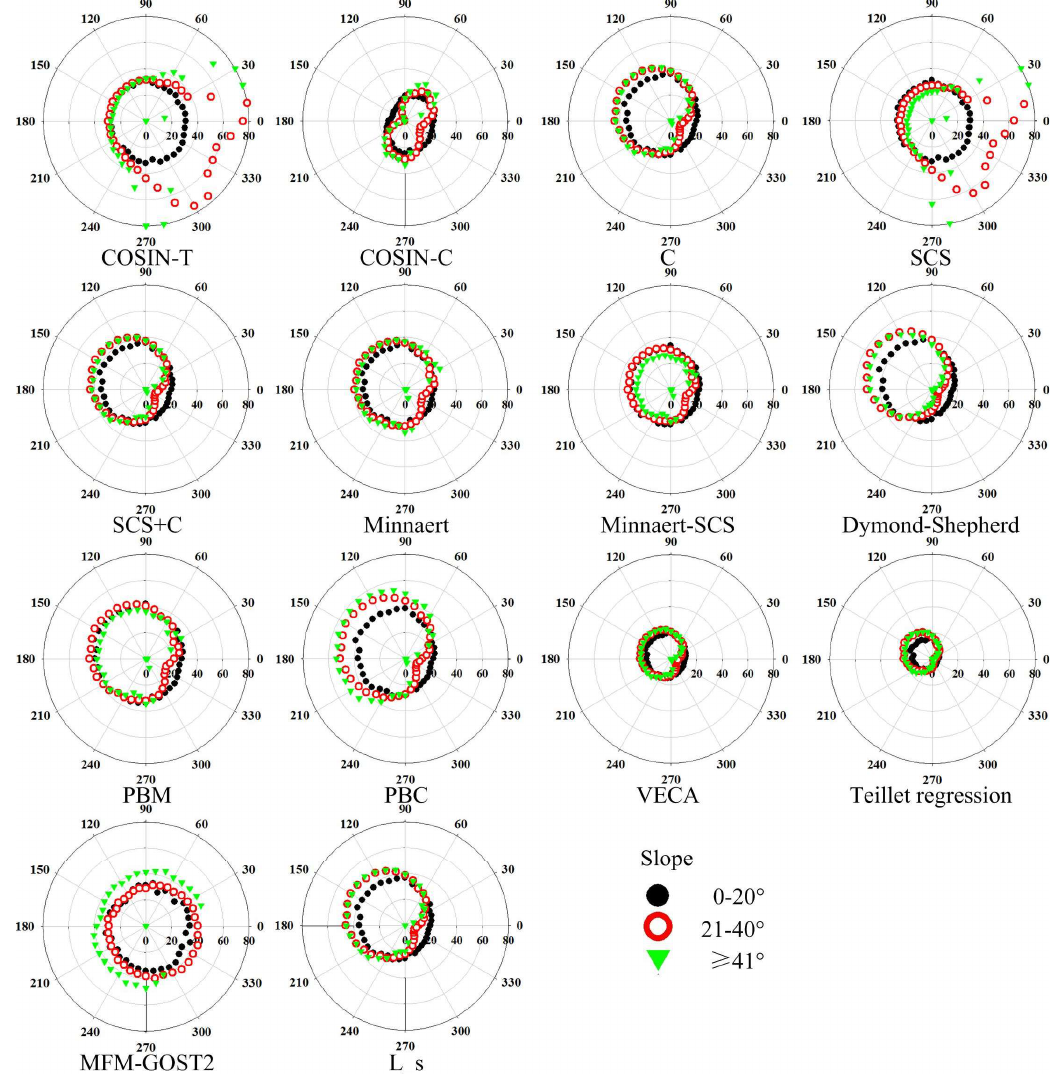
Figure 6. Changes of mean radiances in the NIR band with the aspect at fixed slope intervals in the study area. The polar angle represents the aspect of background (°), and the radius represents the value of radiances (W/(m 2 ·sr·μm)). L_s is the uncorrected radiance.